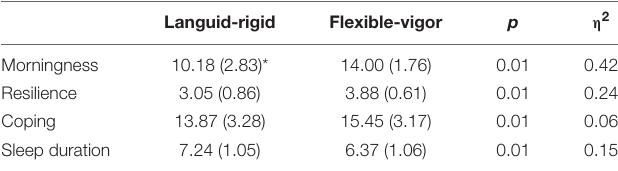
TABLE 4 | Mean scores and effect size for Languid-rigid ( n = 124) and flexible-vigor ( n = 133) types by dependent variables. Languid-rigid